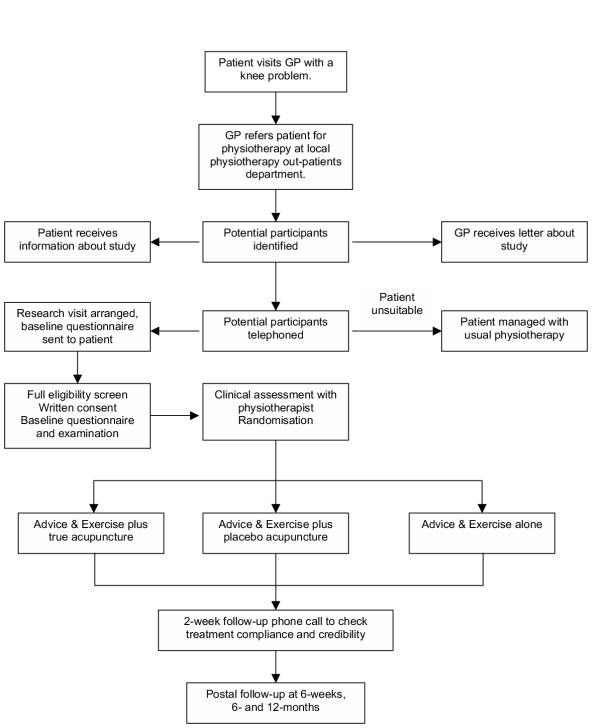
APEX Knee Study Schema